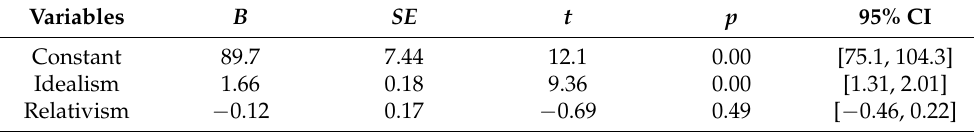
Table 9. Regression coefficient of idealism and relativism on concern for animal welfare (N = 450). Variables B SE t